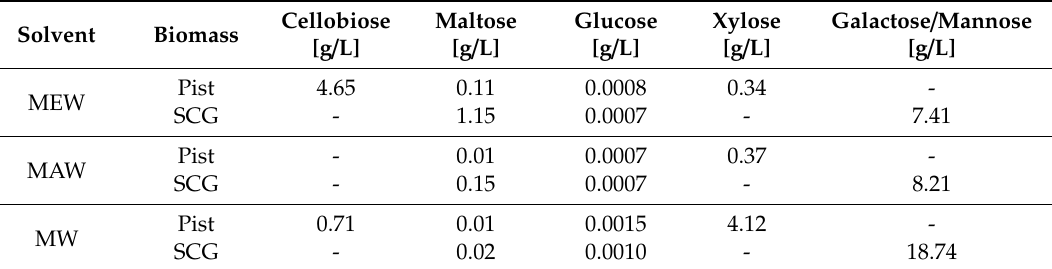
Table 2. Sugar content of HEF samples based on HPLC